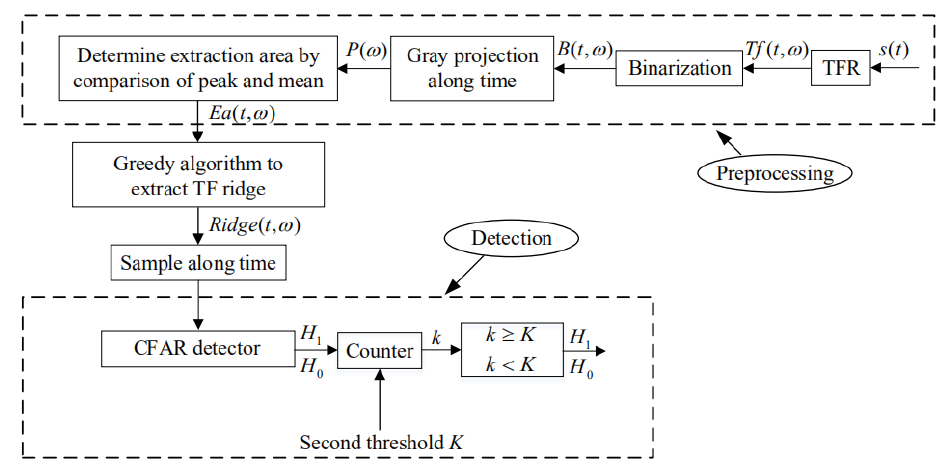
Figure 3. Block diagram of joint TF-CFAR detector.